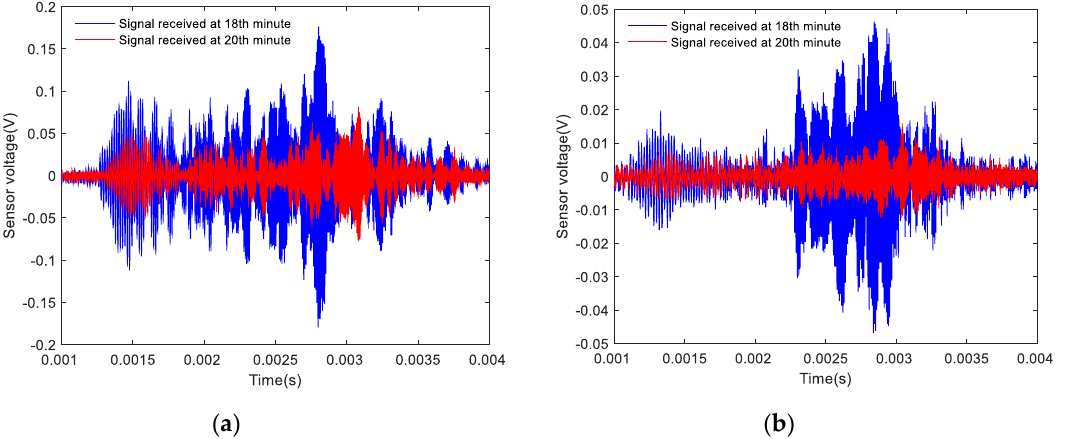
Figure 17. Time-domain signal diagram of Composite specimen II before and after damage: ( a ) Measured signal by SA 3; ( b ) Measured signal by SA 4.